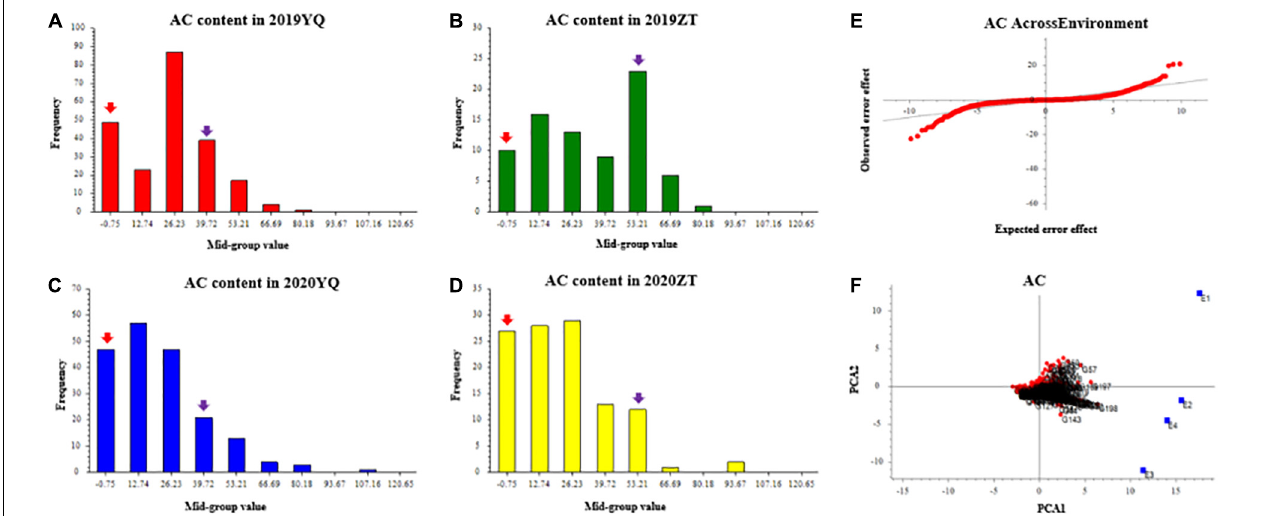
FIGURE 1 | The frequency distribution of anthocyanin content of mapping population in YQ and ZT experimental plantations in 2019 and 2020. Panels (A–D) were the AC distributions in different plots. The x-axis indicates the AC content; the y-axis indicates frequency. The red and purple arrows indicate the mean value of “Meiguohong” and “Xuzishu8,” respectively. (E) Quantile-quantile plot of AC across environment; (F) GGE bi-plot of AC. The AC content in four experiments (E1: 2019YQ, E2: 2019ZT, E3: 2020YQ, E4: 2020ZT) was the average of three blocks. AC, anthocyanin content.